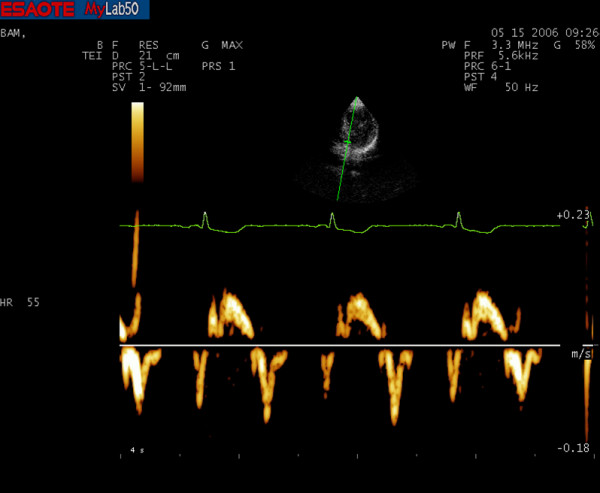
PW-TDI spectrum of a master athlete's heart.